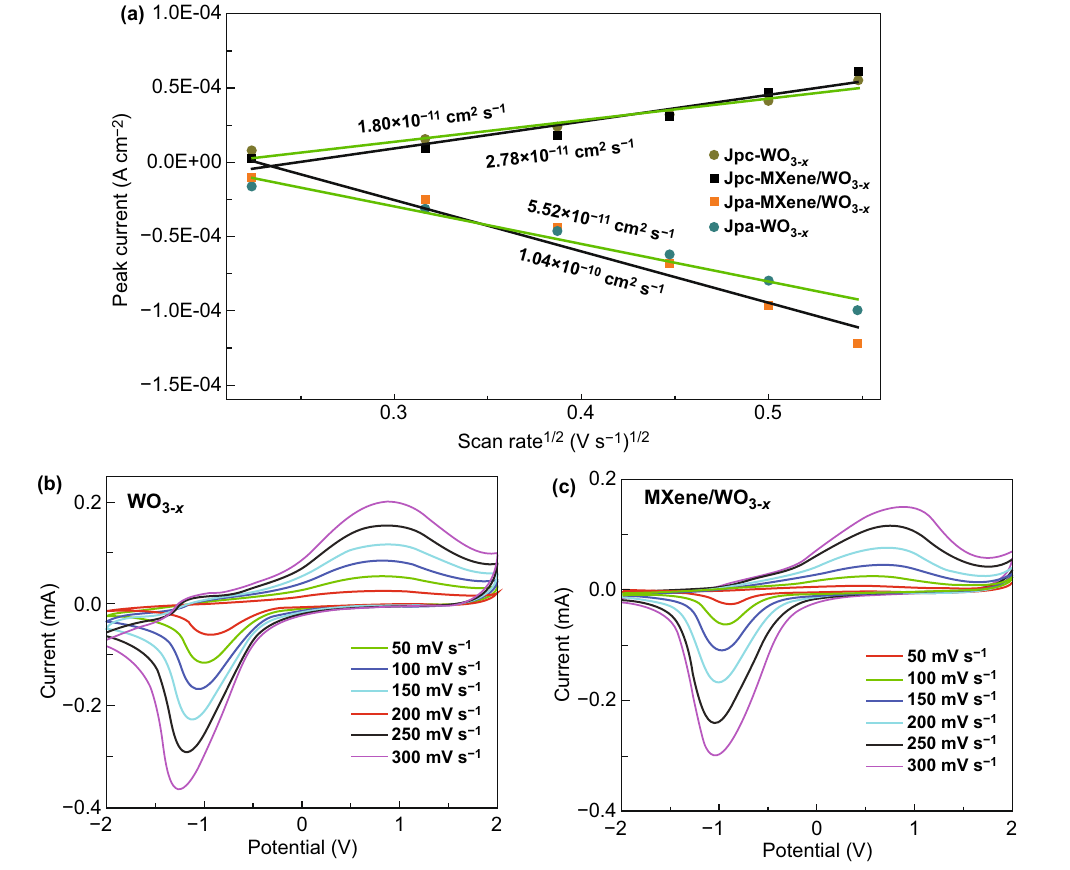
Fig. 5 a Diffusion coefficient of WO 3− x film with and without MXene addition. Cyclic voltammogram of the device based on b pure WO 3− x film and c MXene/WO 3− x film